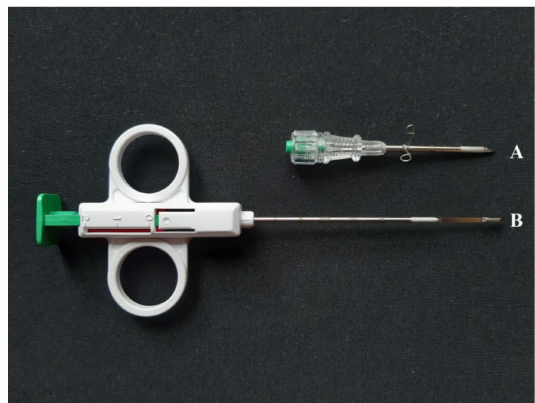
Figure 1. SuperCore TM Biopsy Instrument (B) (14 G × 9 cm) with Co-Axial Introducer Needle ( A ) (13 G × 3.9 cm). The biopsy needle has two tension points to pre-tension it, as the numbers 0, 1, and 2 illustrate. In the present study, tension was applied up to the second (2) tension point. At the tip of the biopsy needle ( B ) is the recess where the tissue sample can be found after the plunger has been